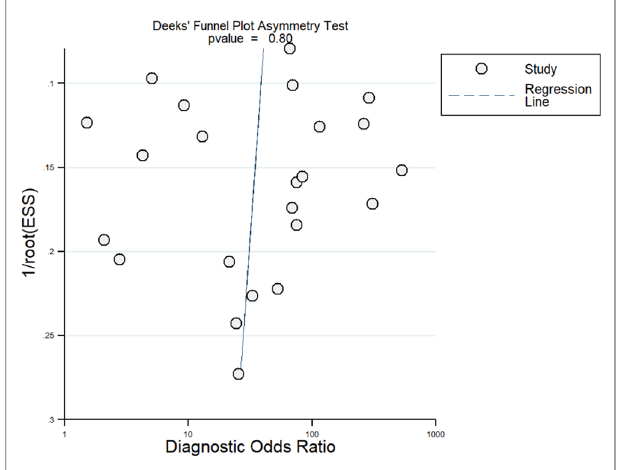
FIGURE 9 | Funnel plot for